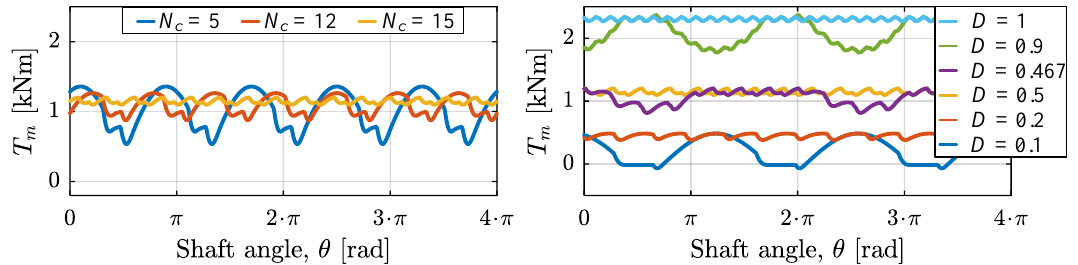
Figure 19. Steady-state response FSDS with various numbers of cylinders ( left plot ) and at various displacements ( right plot ).